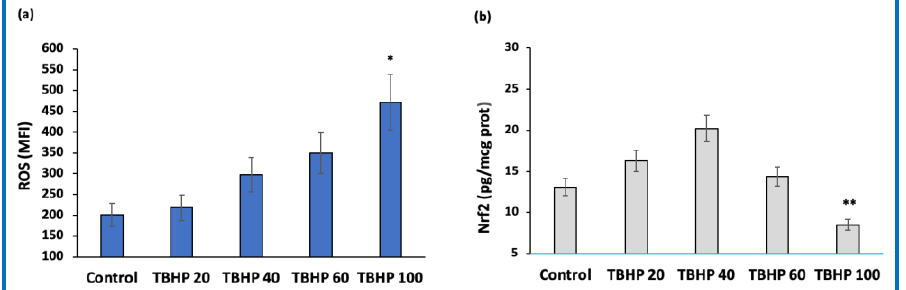
Figure 3. Effect of different degrees of oxidative stress on intracellular reactive oxygen species (ROS) formation and Nrf2 nuclear translocation in THP-1 cells. ( a ) ROS formation in cells exposed to in- creasing concentrations (from 20 to 100 μ M) of tert-butyl hydroperoxide (TBHP). ( b ) Nrf2 nuclear translocation in cells exposed to increasing concentrations (from 20 to 100 µ M) of tert-butyl hydroper- oxide (TBHP). Data represent the mean +/ − standard deviation of measurements performed in triplicate in three different experiments; * p < 0.01 increase vs. control; ** p < 0.01 decrease vs. control.